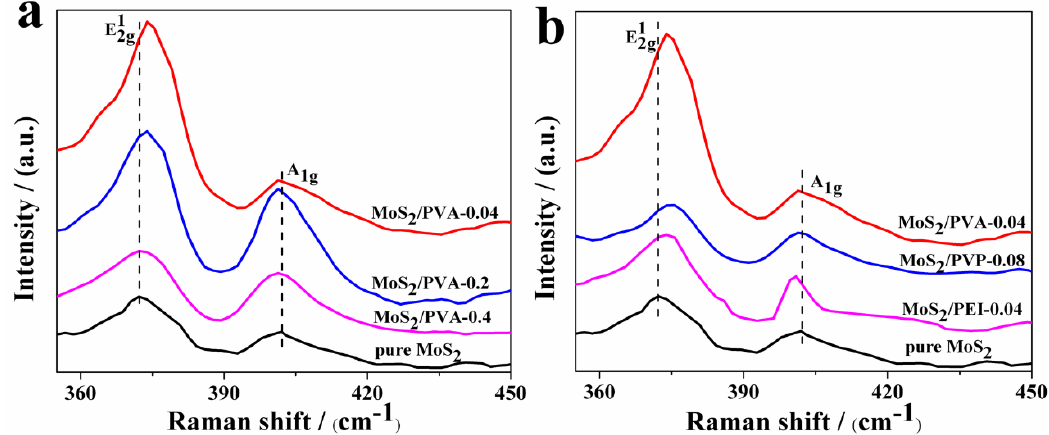
Figure 2. Raman spectra of various MoS 2 -based nanoflower-like catalysts: ( a ) MoS 2 /PVA composite; ( b ) MoS 2 /PVA–0.04, MoS 2 /PVP–0.08, and MoS 2 /PEI–0.04